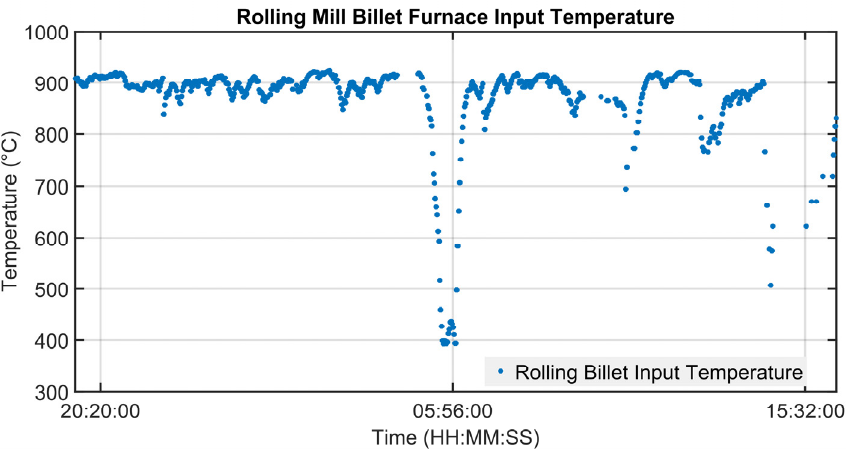
Figure 9. Control results: billets temperature at furnace inlet pyrometer.